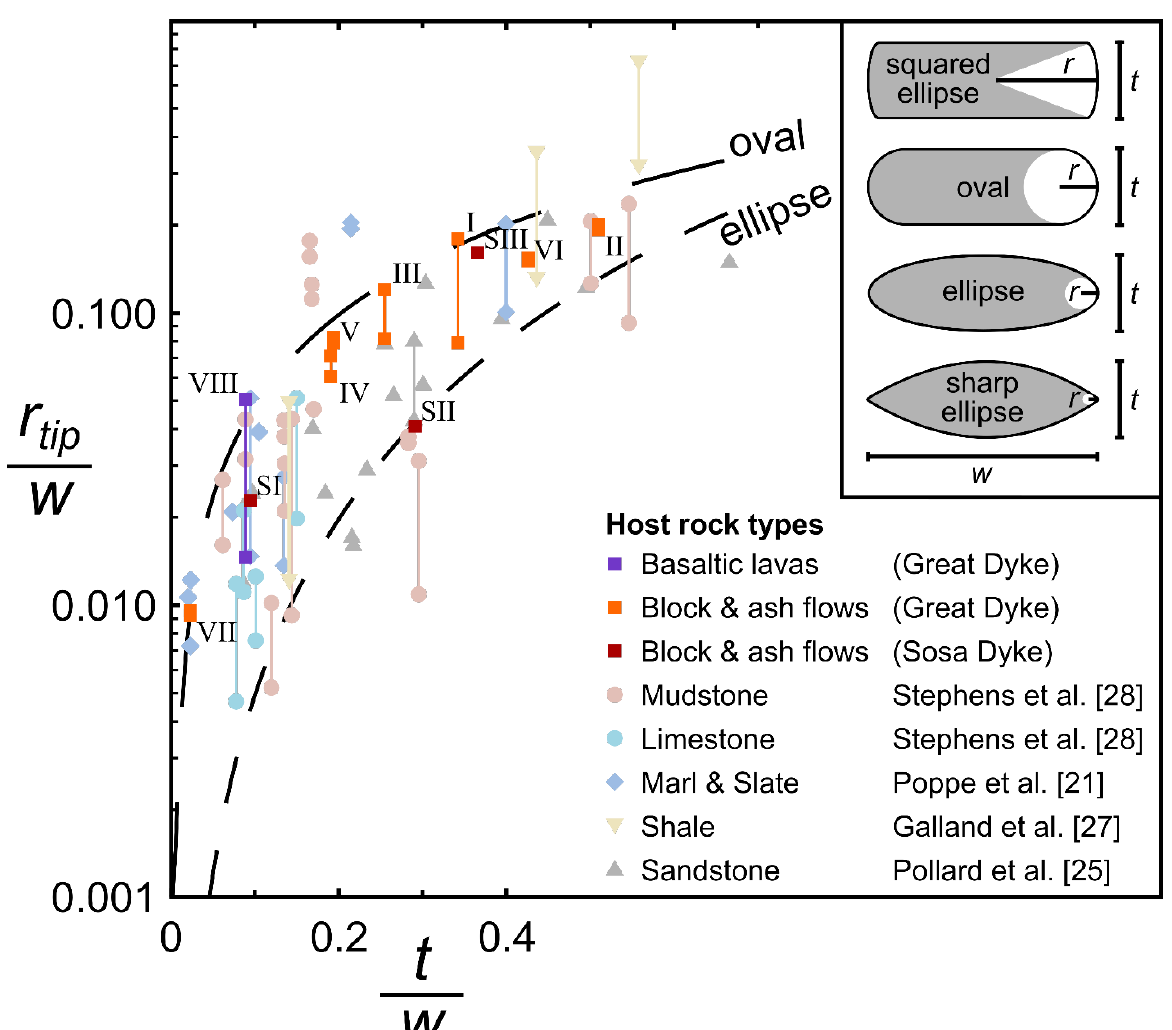
Figure 9. Dyke segment geometries. The plot is redrawn and modified after Pollard et al. [25] and Stephens et al. [28]; squares represent data from this study. Roman numbers correspond to the segments of the Sosa Dyke ( SI-SIII ) and the Great Dyke ( I-VIII ) in Figure 2 and Figure 4, respectively (Data: Appendix C). Colours represent different host rocks. The vertical line indicates two data points belong to the same segment (e.g., left and right tip of a segment); no line, means only one data point (tip) was observed for that segment. t — segment thickness, w — segment width, r tip — radius of segment tip curvature. (inset) Schematic simplification of the different types of observed intrusion segment shapes and their parameters; squared ellipses can be expected in the plot above the “ oval ” line, whereas sharp ellipse shapes are displayed below the “ ellipse ” line.